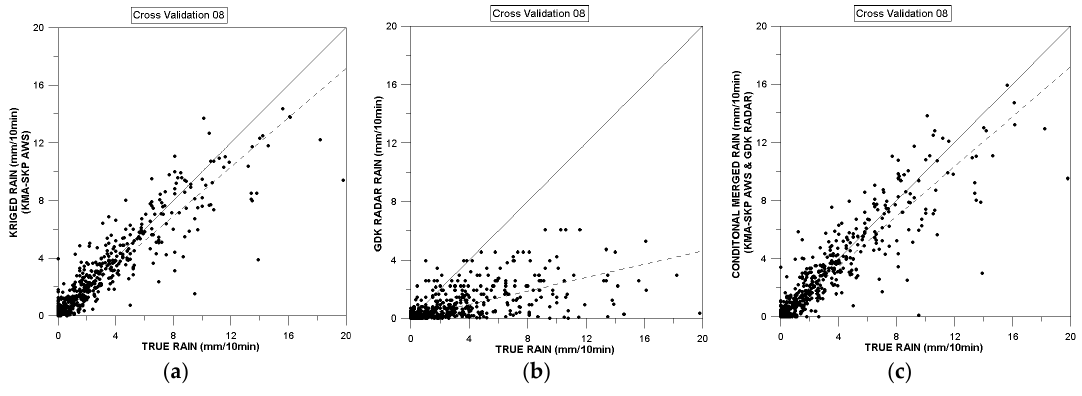
Figure 3. Scatter diagrams of three quantitative precipitation estimation products by cross validation for 22 July 2013: ( a ) QPE 1; ( b ) QPE 2; ( c ) QPE 3. Table 2. Statistics of the comparison between the cross-validation estimates of each quantitative precipitation estimations and rain gauge observations.